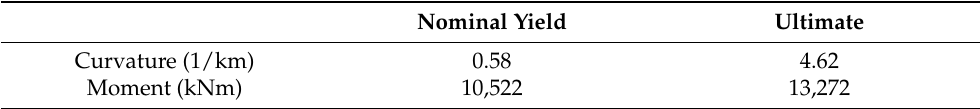
Table 7. Bi-linear moment–curvature results of